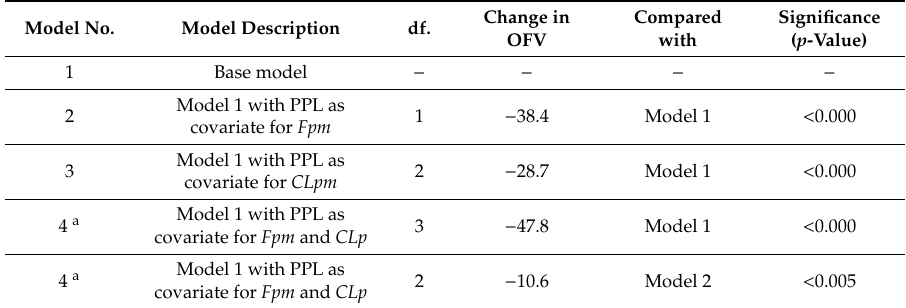
Table 1. Summary of covariate model building